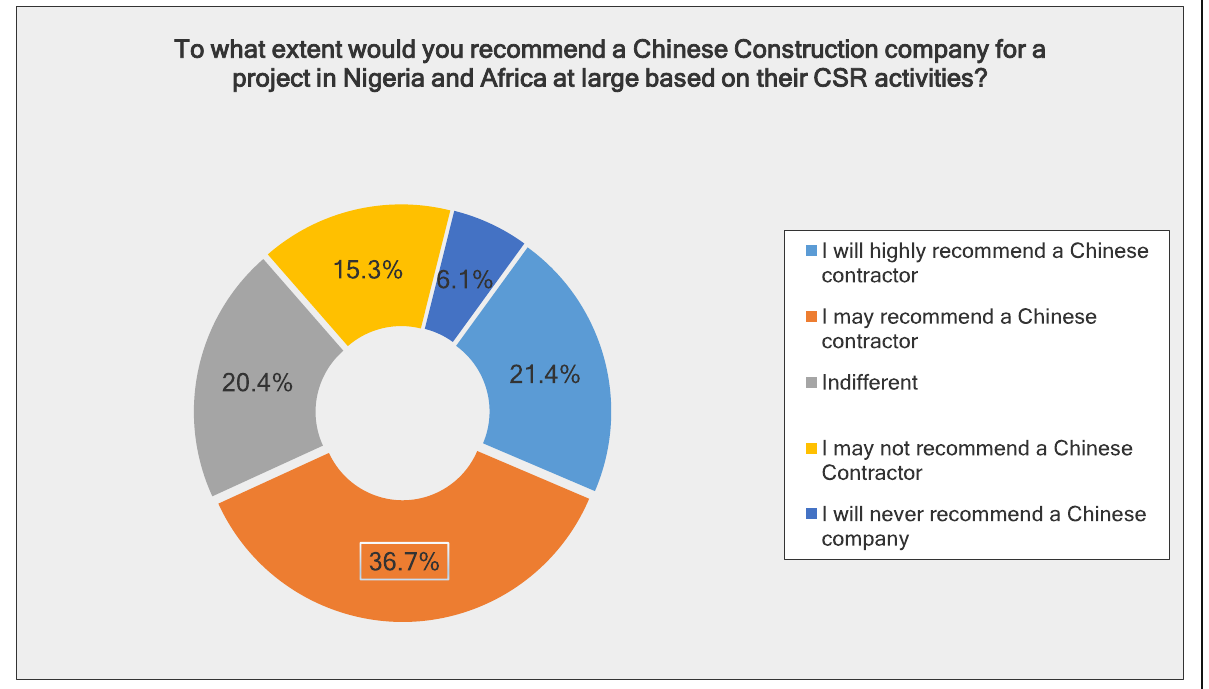
Fig. 2 Futuristic outlook of Africans regarding CICCs based on